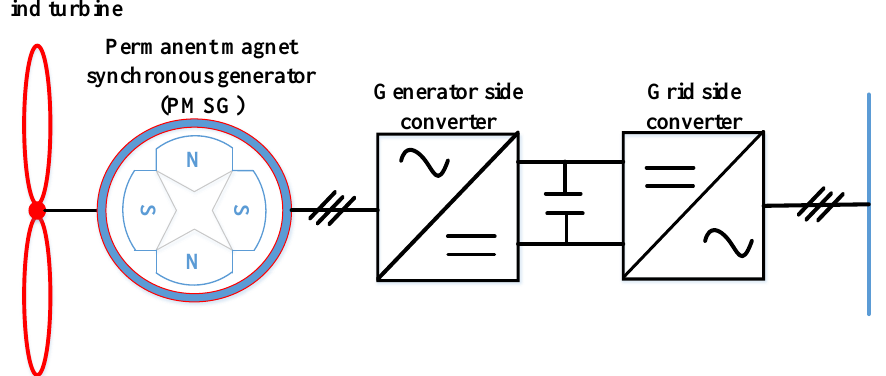
Figure 7. A permanent magnet synchronous generator (PMSG) wind energy conversion system [63].